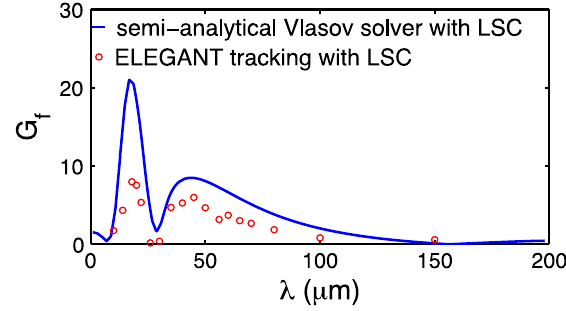
FIG. 7. (Top) Longitudinal phase space distribution at s ¼ 410 m. (Bottom) Bunch current density. Note here the bunch head is to the